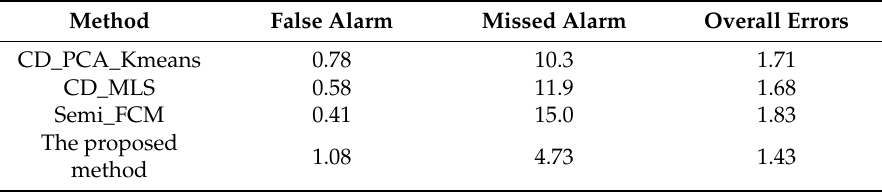
Table 3. Change Detection Quantitative Evaluation (%) on the Mexico Dataset (more details can be tracked in Table S3.).